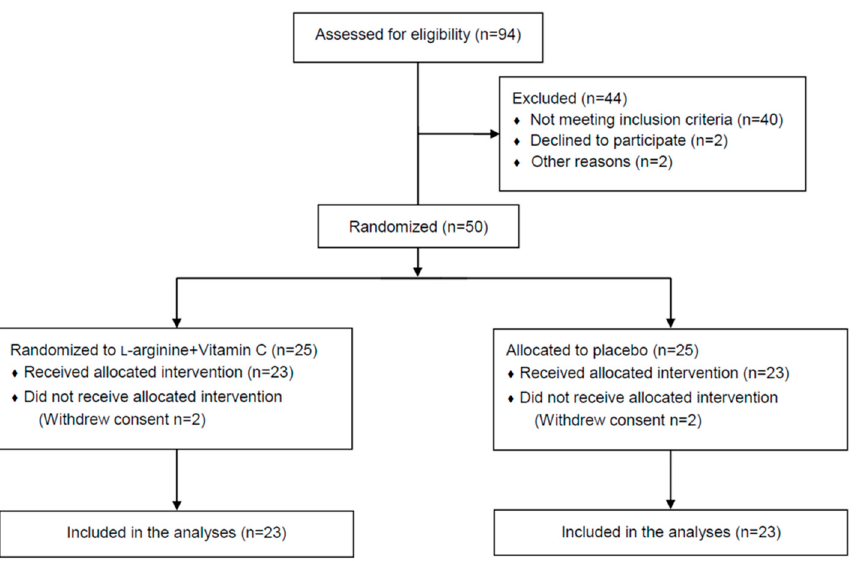
Figure 1. CONSORT diagram of participant flow through the study.